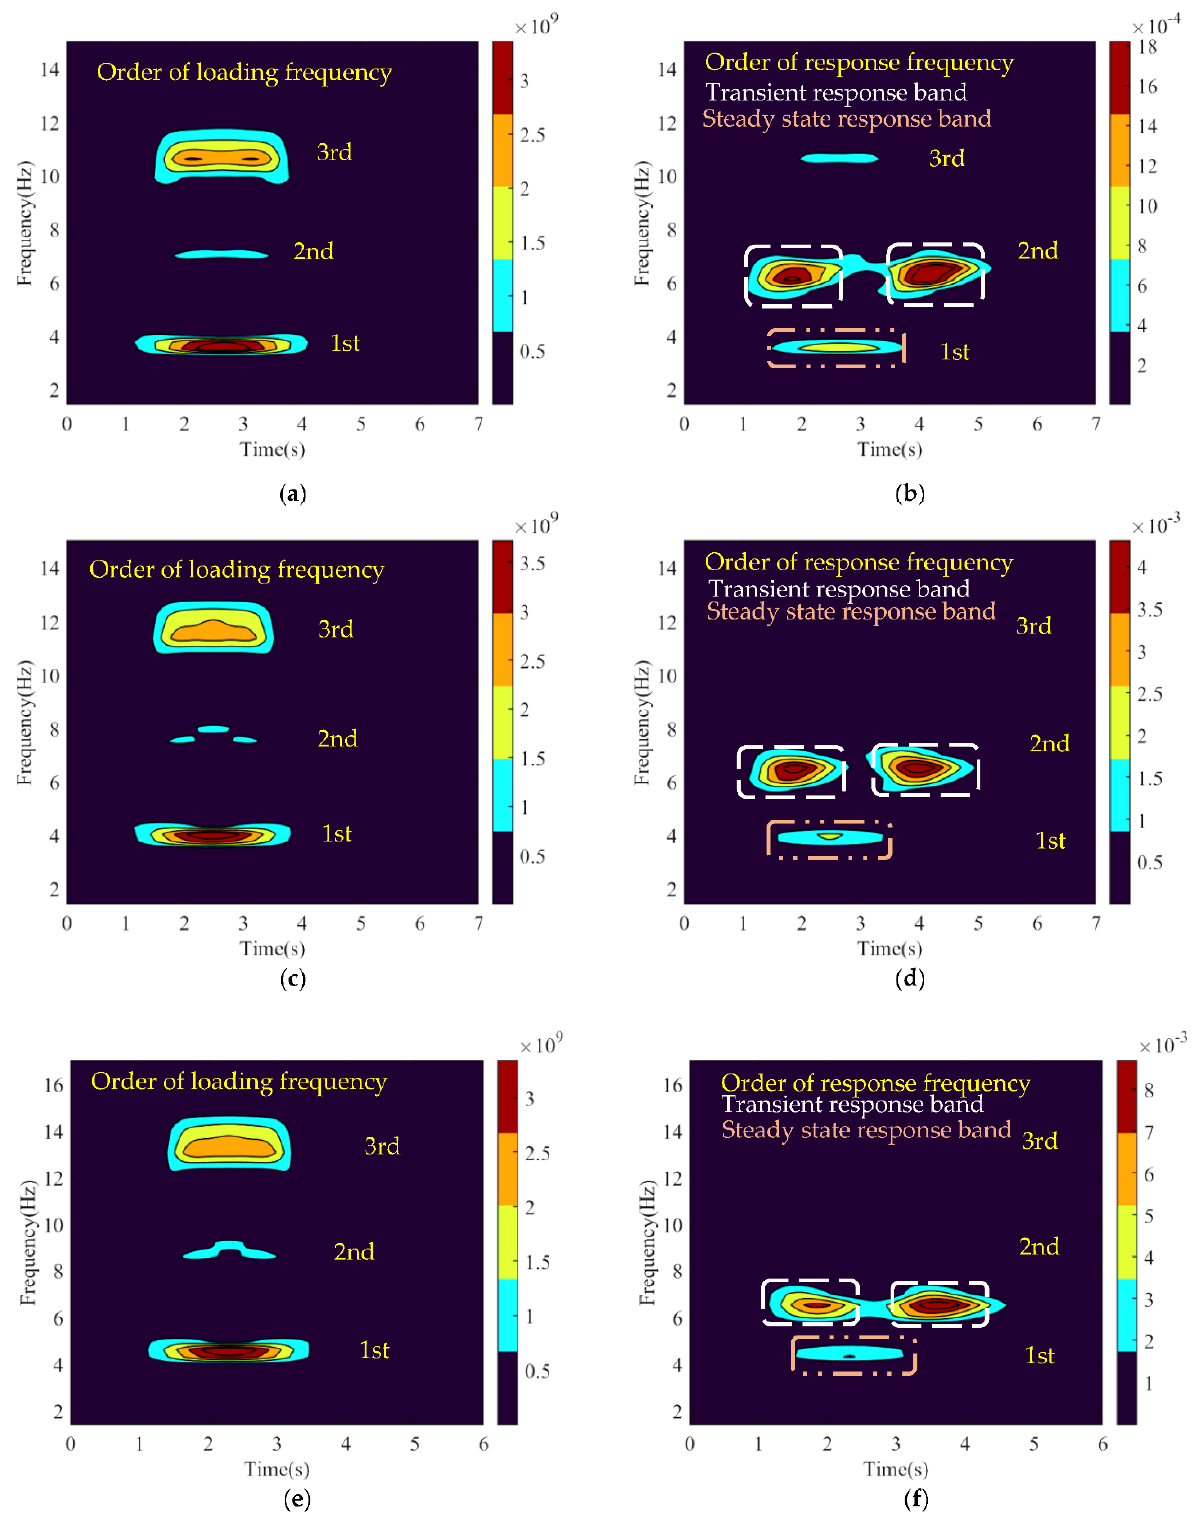
Figure 9. Scalogram from excitation to vertical vibratory resonant acceleration response at mid– span bridge: ( a ) Excitation scalogram at train speed of 320 km/h; ( b ) Bridge response scalogram at train speed of 320 km/h; ( c ) Excitation scalogram at train speed of 350 km/h; ( d ) Bridge response scalogram at train speed of 350 km/h; ( e ) Excitation scalogram at train speed of 400 km/h; ( f ) Bridge response scalogram at train speed of 400